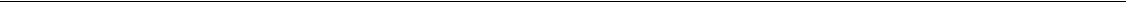
Fig. 1 Micro fl uidic setup. a Chip design. A total of 16 syringes with aqueous samples are connected to the inlets in the micro fl uidic chip via tubing (10 with compounds, 2 with medium to generate single drug and control conditions, 2 for barcoding, 1 for the cell suspension, 1 with Caspase-3 substrate to detect apoptosis). Other 2 inlets in the micro fl uidics chip are used for carrier oil (FC-40) and mineral oil. The braille display unit is used to control the valves (red coloured circles) and regulate the fl ow coming from the aqueous phase syringes, resulting in different combinations. Plugs are collected in a tube connected to the outlet. b Experimental setup. Micro fl uidic chip mounted onto a Braille display aligning the micro fl uidic channels with the braille valves. c , d Cross section of a valve mounted on the Braille display in the open and closed con fi guration. e Combinatorial plugs production. Single compounds and pairwise combinations are automatically generated. First barcode (BC) plugs are generated followed by the corresponding assay plugs for each condition. f Storage of plugs. Plugs are stored in PTFE tubing for incubation and readout purposes. g Array of binary barcodes in a micro fl uidic channel. Plugs contain two different dyes (bright colour indicating a “ 1 ” , dark color indicating a “ 0 ” ) were used to generate binary numbers 40 –